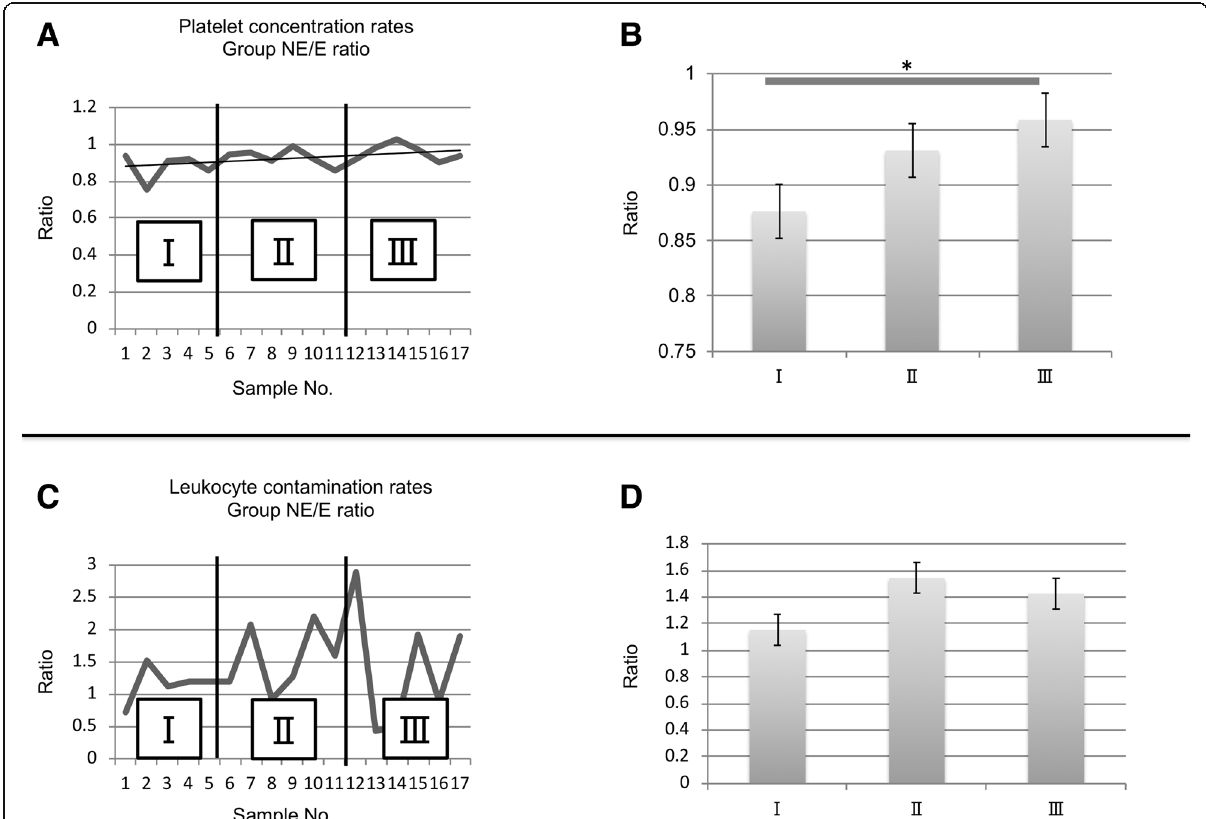
Fig. 2 a Platelet concentration rates in Group E and NE ratio were divided into three stages in the preparation procedure (stage I: 5 samples, stage II: 6 samples, stage III: 6 samples). b A significant difference was shown between stage I and stage III in platelet concentration rates of Group NE/E ratios ( p <0.05). c Leukocyte contamination rates in Group E and NE ratio were divided into three stages in the preparation procedure (stage I: 5 samples, stage II: 6 samples, stage III: 6 samples). d Leukocyte contamination rates of Group NE/E ratio showed no significant differences at